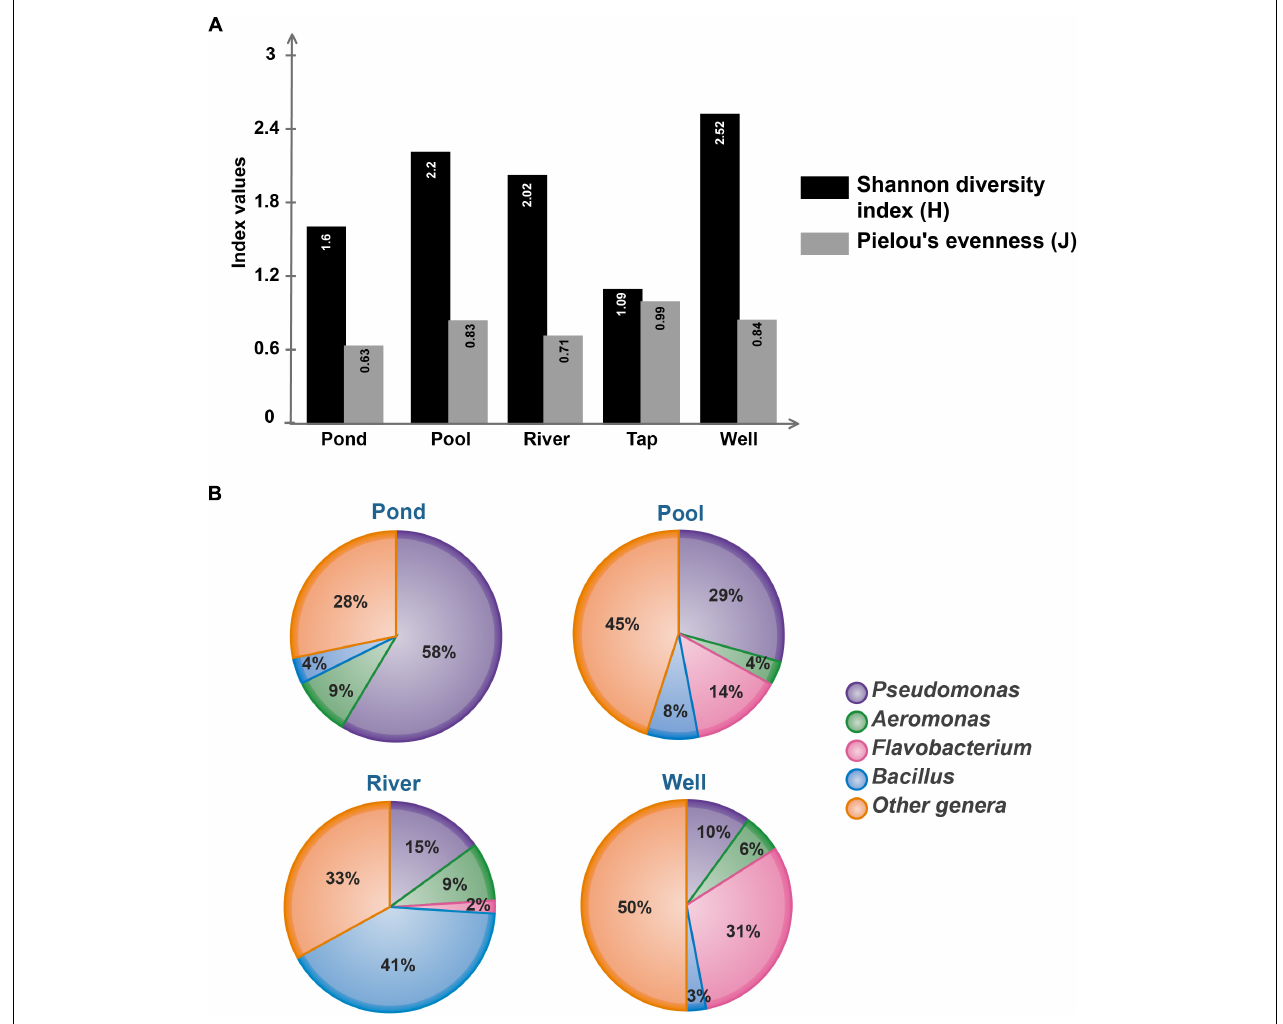
FIGURE 3 | Microbial diversity of environmental water sub-collections. (A) Bacterial communities’ richness and evenness from each water sub-collection, as estimated by Shannon and Pielou indexes, respectively. Calculation were performed using R package vegan (Oksanen et al., 2018). (B) Relative abundances of the most represented (i.e., dominant) genera in each water sub-collection. The tap water condition is not represented by a circular diagram since this sub-collection harbors only three bacterial genera, namely Bradyrhizobium , Sphingobium, and